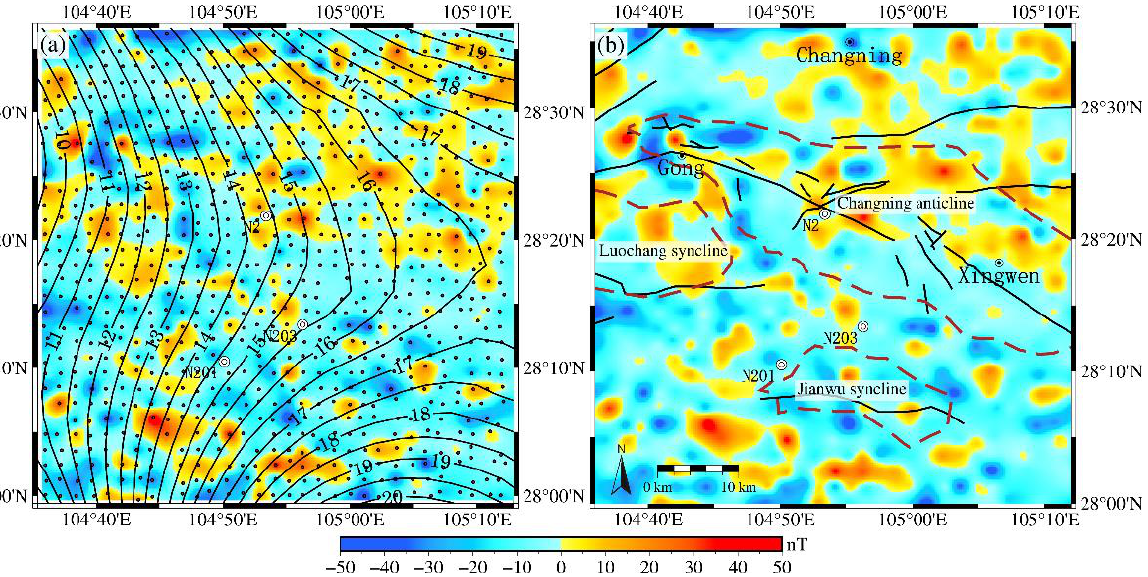
Figure 3. Magnetic anomalies in the Changning area. Black solid contour lines indicate magnetic anomalies given by EMAG2v3 in ( a ). In ( b ), the black lines represent the fault line in the Changning area, including tectonic lines and surveyed faults [5,17]. The brown lines are the fold structure in the study area.